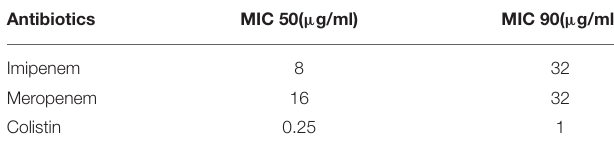
TABLE 2 | MIC50 and MIC90 of carbapenems and colistin.